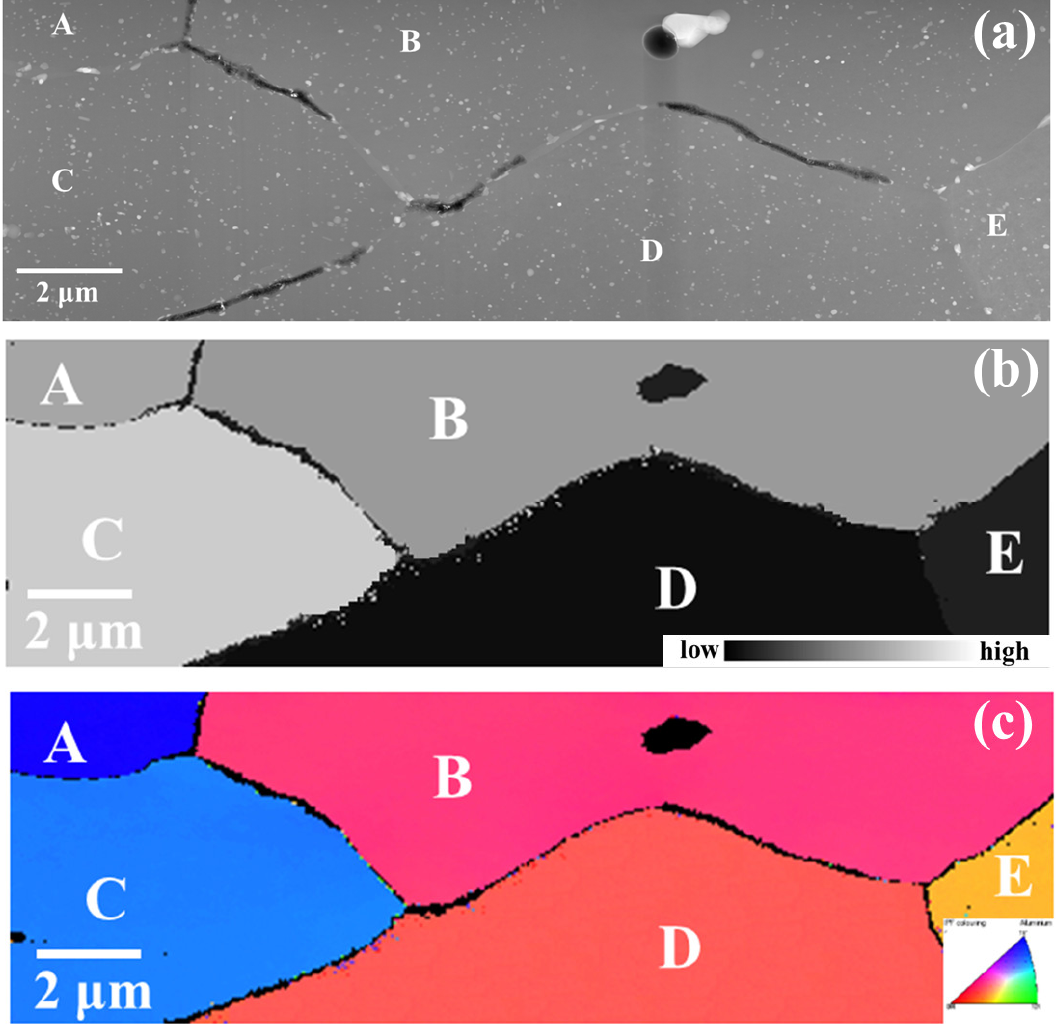
Figure 4. ( a ) HAADF micrograph of the cross-section of a typical localized corrosion site in AA2024-T3 alloy after 10 h immersion in a 3.5 wt % NaCl solution; ( b , c ) the corresponding distributions of stored energy in grey scale and grain orientation in IPF colouring.